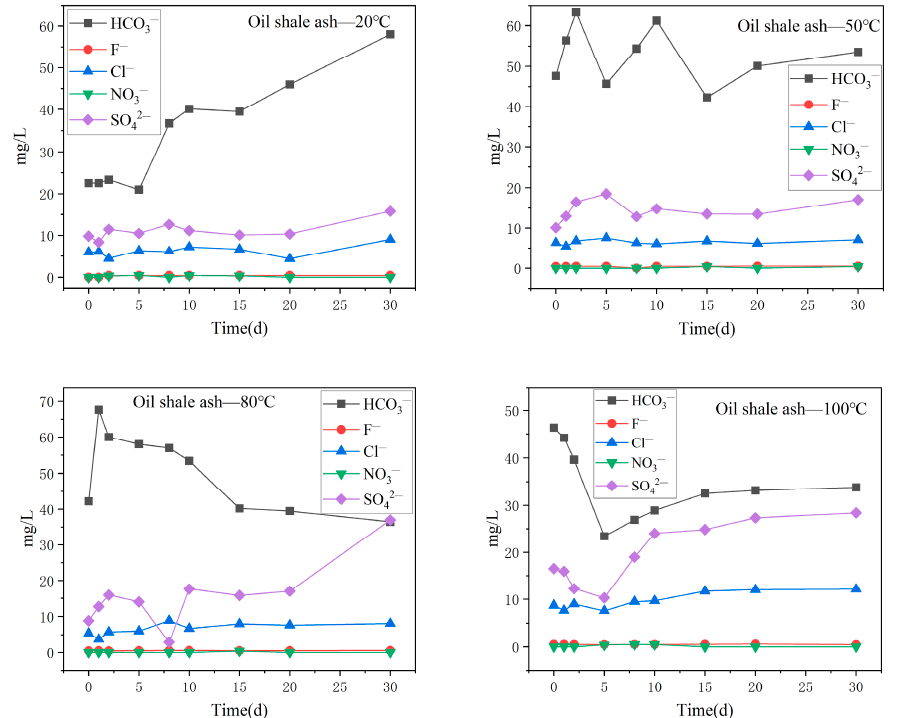
Figure 8. Variation in the content of the main anions in the oil shale ash aqueous solution under different temperature reaction conditions.